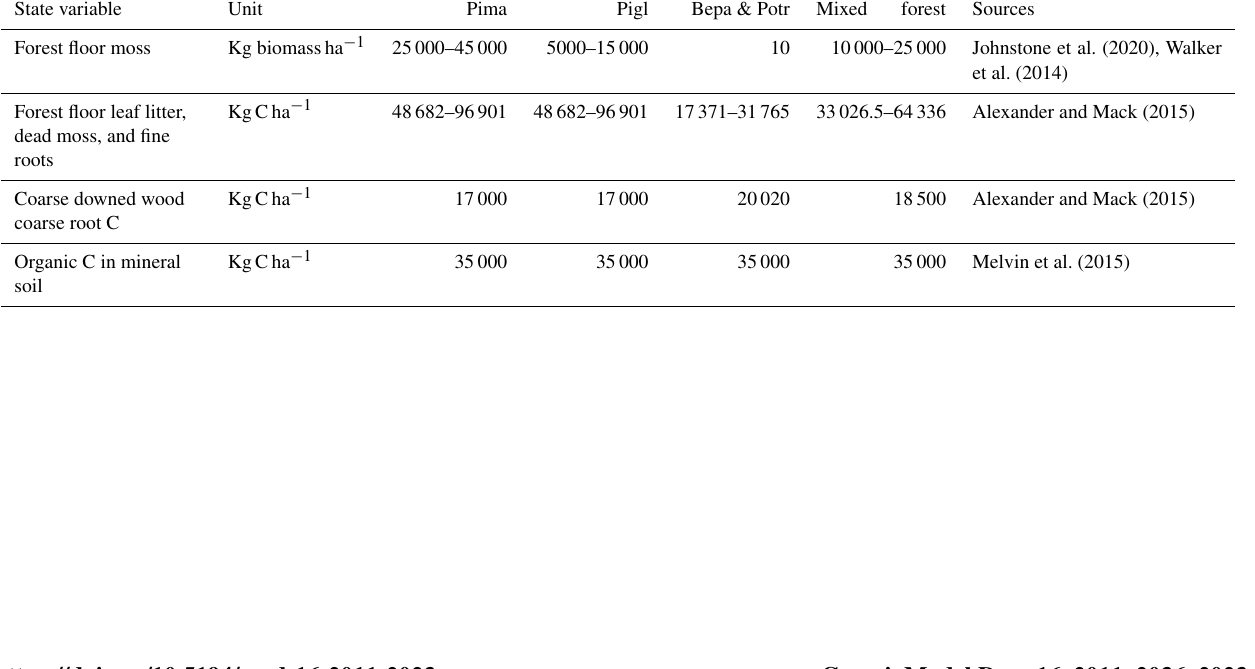
Table B4. Initial conditions for iLand carbon cycle. Pima: Picea mariana (black spruce); Pigl: Picea glauca (white spruce); Potr: Populus tremuloides (trembling aspen); Bene: Betula neoalaskana (Alaskan birch). State variable Unit Pima Pigl Bepa & Potr Mixed forest